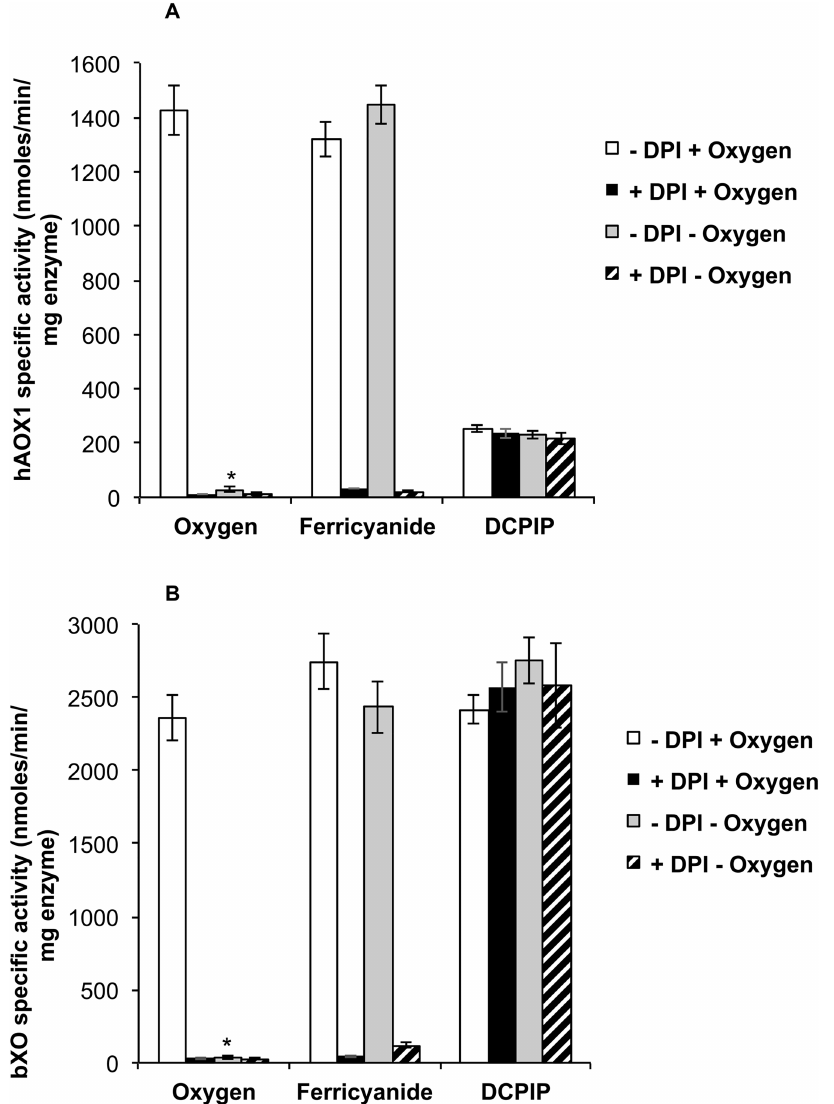
Fig 3. The effect of diphenyleiodonium on hAOX1 activity. Specific activitiesof (A) hAOX wild-typewith 80 μ Mphenanthrineas substrateand(B) of bXO with 50 μ Mxanthineas substrate.Assayswereperformed usingmolecularoxygen(air-saturated buffer)or 500 μ Mferricyanideand100 μ M2,6-dichlorophenolindophenol (DCPIP) as electronacceptors either under aerobic or under anaerobicconditions. The effect of 5 μ M diphenyleneiodonium (DPI) on enzyme activity was assayed under these conditions.